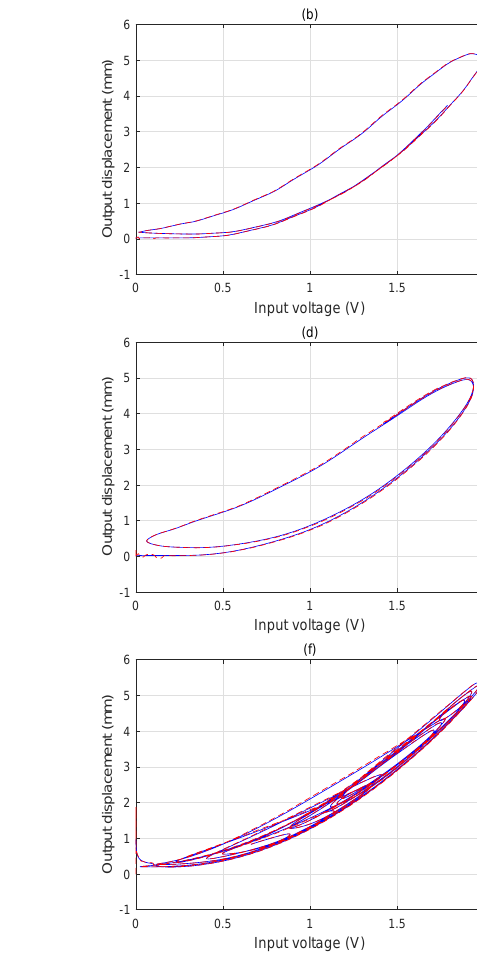
Figure 6. The hysteresis loops of the Hammerstein model under different frequencies. ( a ) 0.1 Hz. ( b ) 0.2 Hz. ( c ) 0.3 Hz. ( d ) 0.4 Hz. ( e ) 0.5 Hz. ( f ) 0.1/0.2/0.3/0.4/0.5 Hz. Red dotted line: output of the Hammerstein model. Blue solid line: output of the DEAP actuator. Table 4. The modeling errors of the Hammerstein model under different